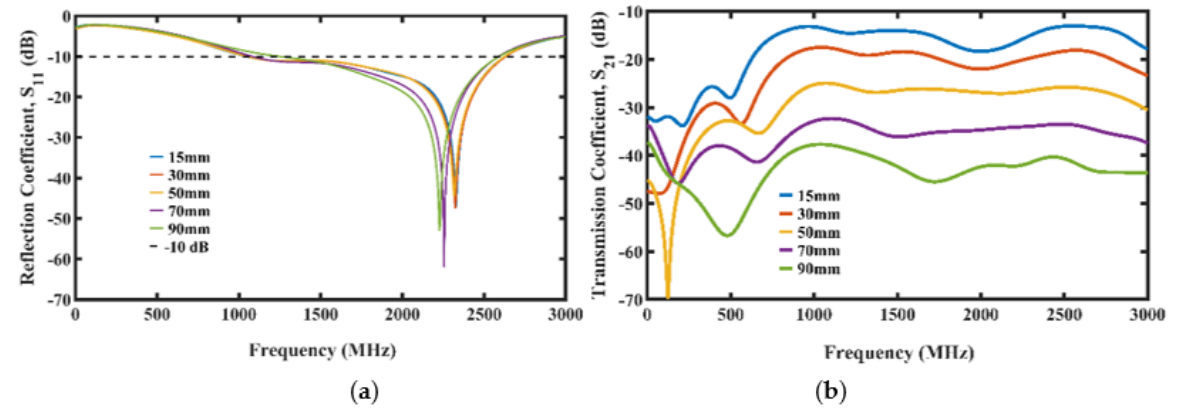
Figure 4. Simulation plot showing different antenna spacing. ( a ) Reflection coefficient. ( b ) Transmission coefficient.